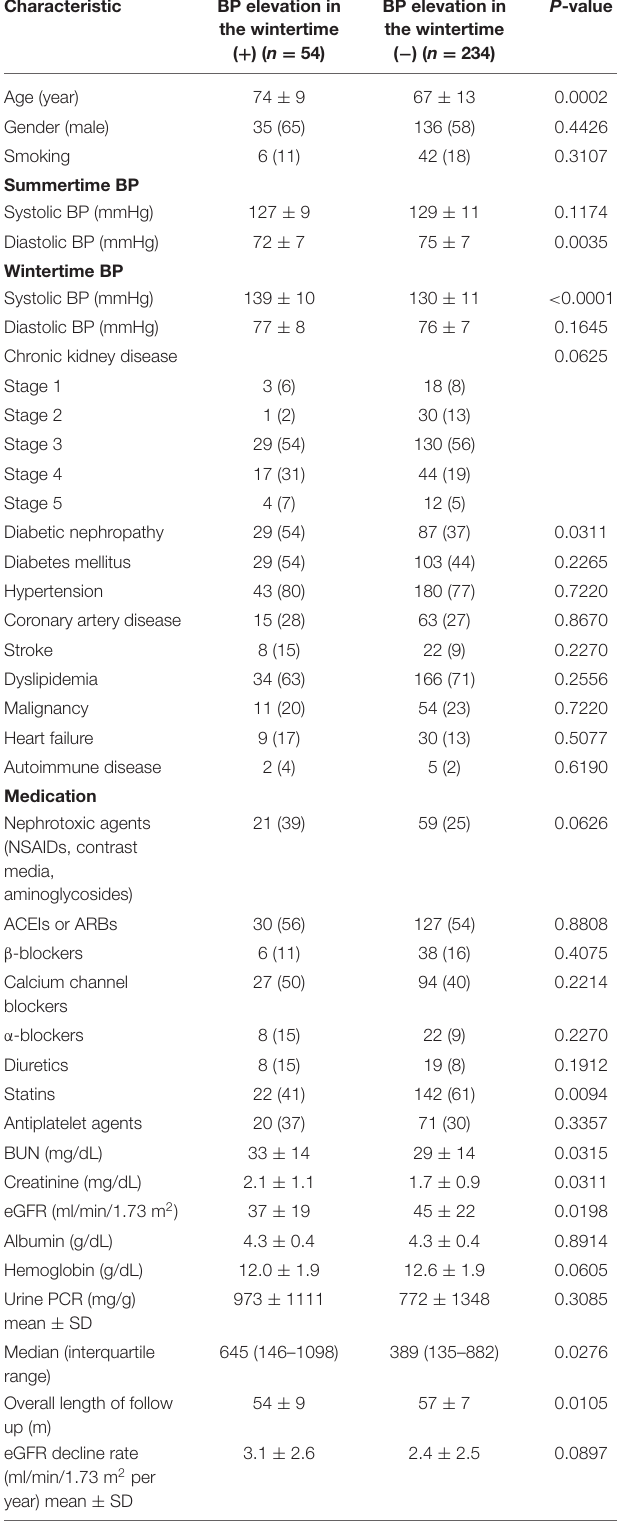
TABLE 4 | Characteristics of 288 CKD patients with home BP monitoring in relation to BP elevation in the wintertime. Characteristic